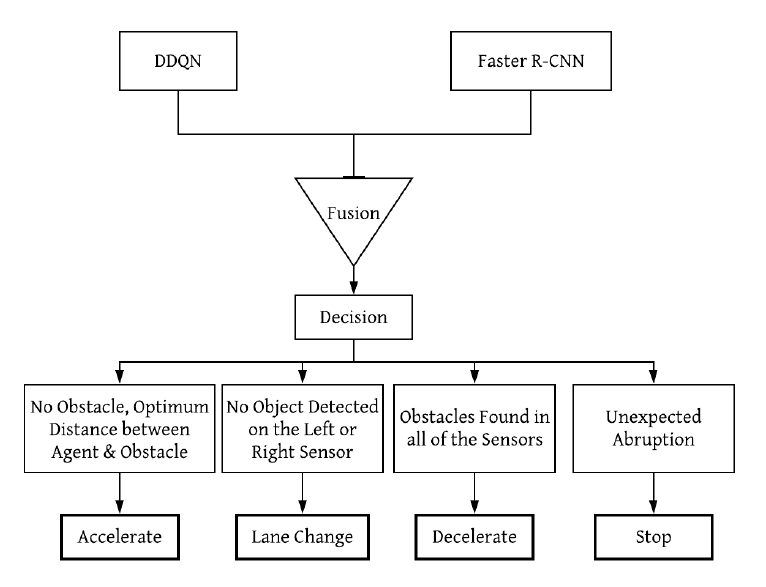
Figure 7. Combined decision-making